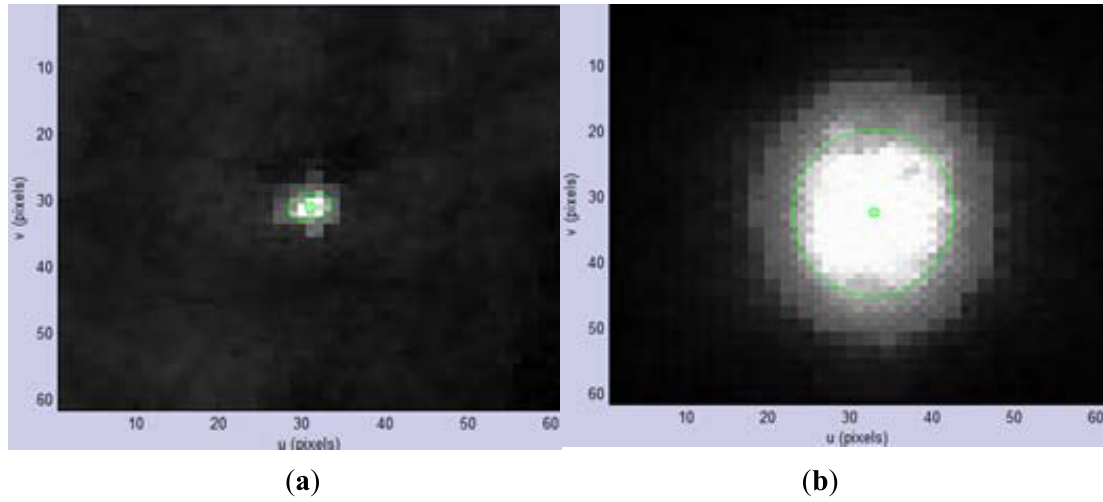
Figure 5. ( a ) Enlarged picture around the detected center at a distance of 5 m from the wall; ( b ) Enlarged picture around the detected center at a distance of 0.5 m from the